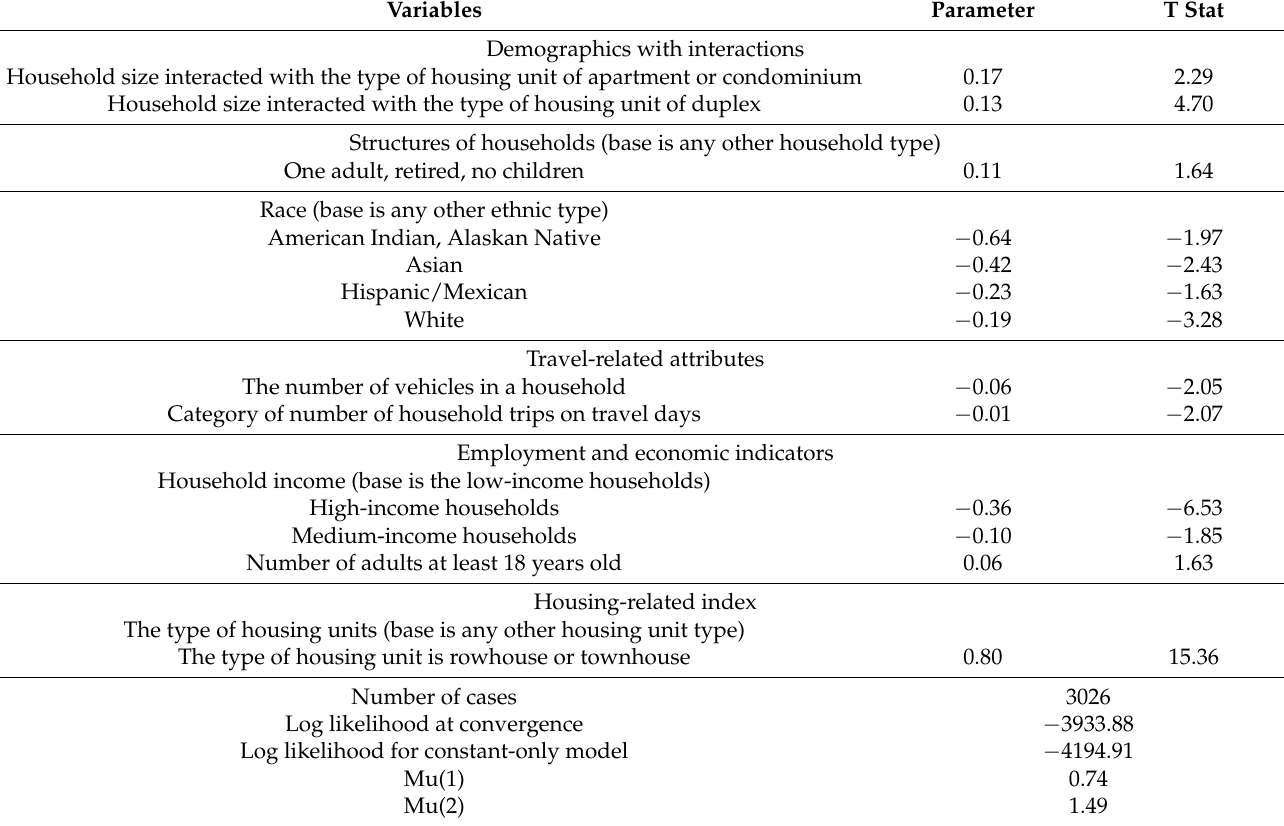
Table 5. Ordered response model of residential choice of housing density at census tract level. Variables Parameter T Stat Demographics with